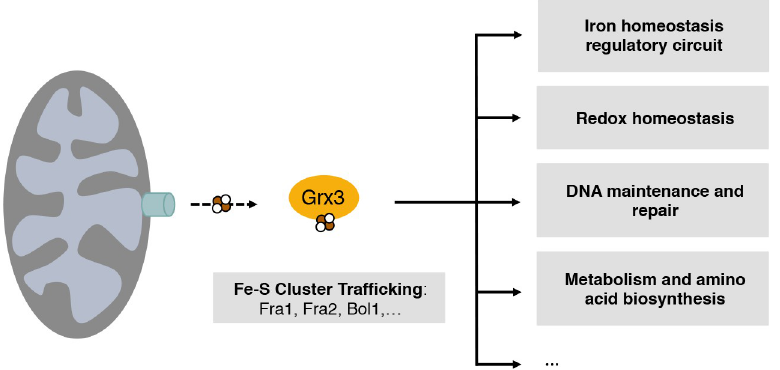
Fig 6. Grx3 is a global iron sensor and Fe-S carrier critical for the function of multiple Fe-S protein-dependent pathways. Cartoon of global Grx3 function. The Fe-S cluster-carrying protein Grx3 is an intracellular iron sensor and Fe-S trafficker that contributes to the function of a multitude of proteins involved in a wide range of biological processes as listed.